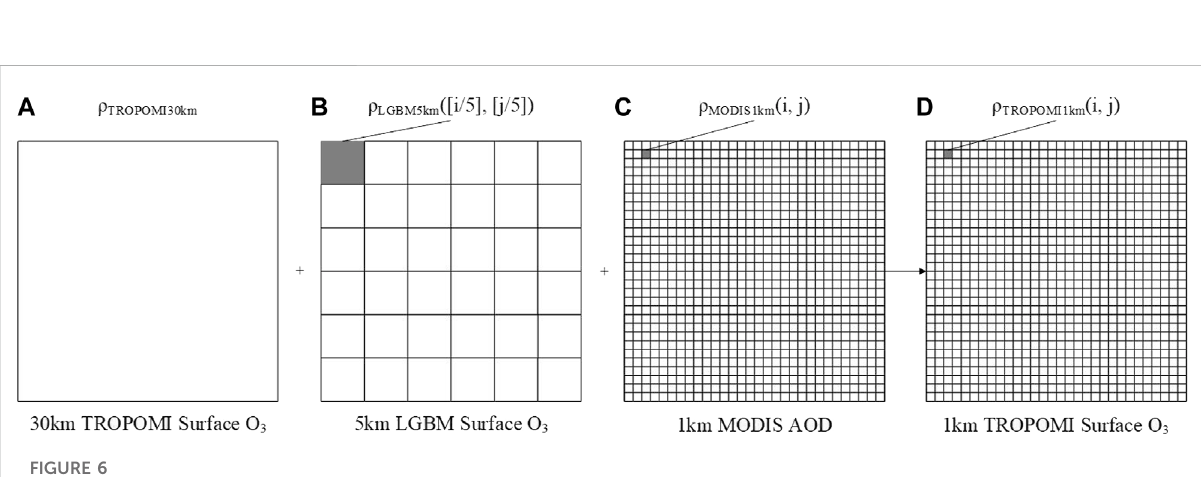
FIGURE 6 Downscaling of 30 km TROPOMI surface O 3 pixel to 1 km